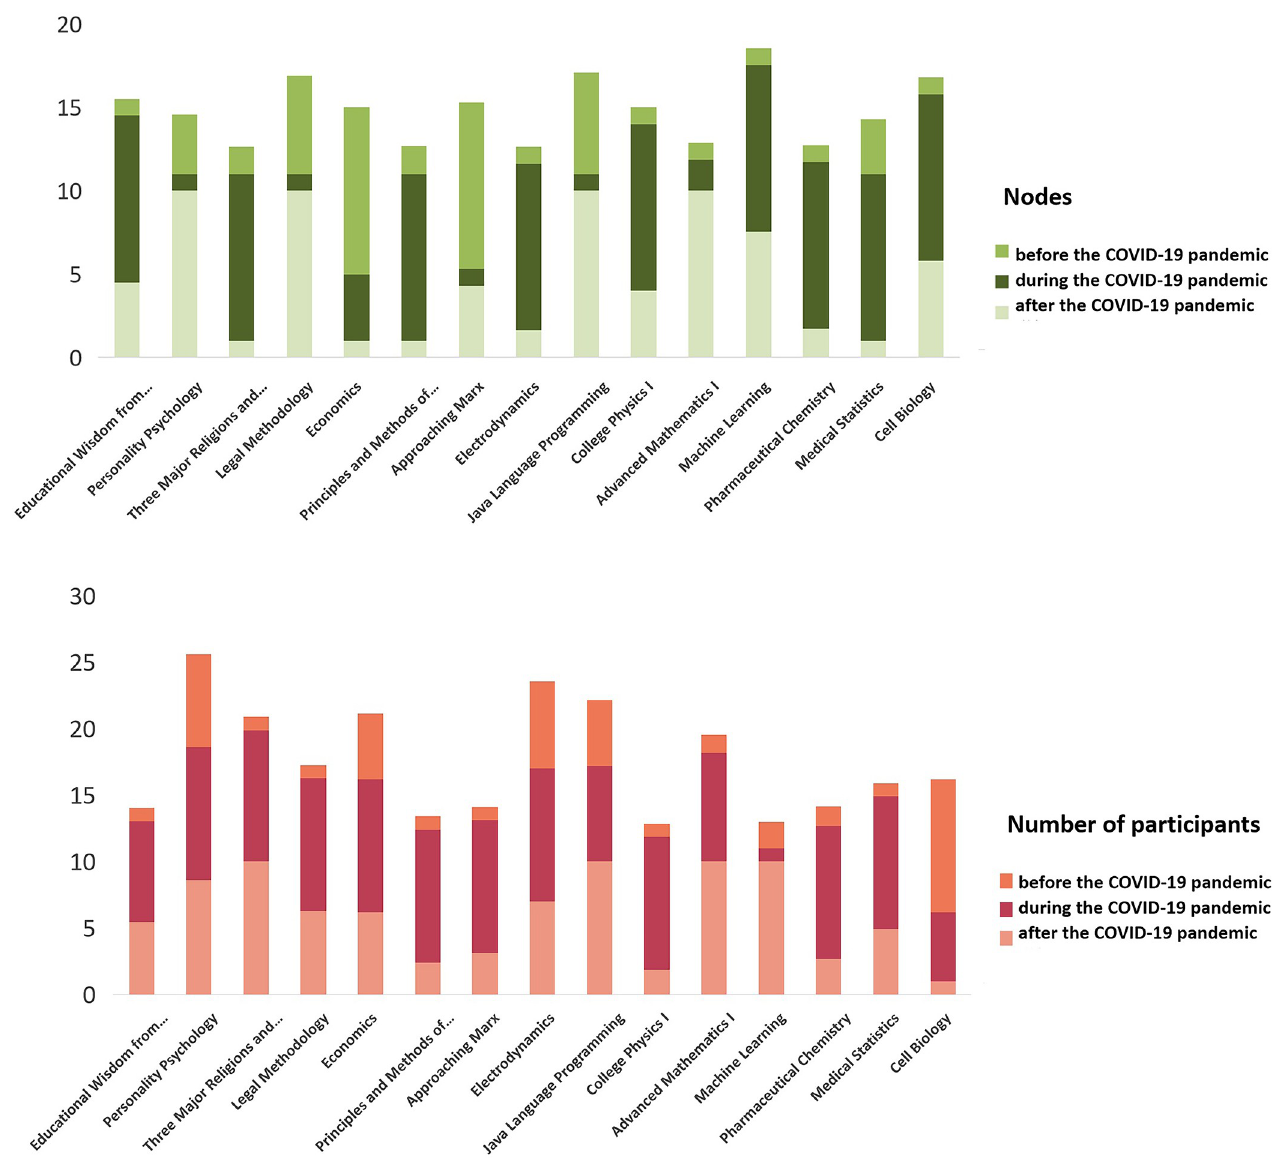
Fig 2. Participants and nodes in course